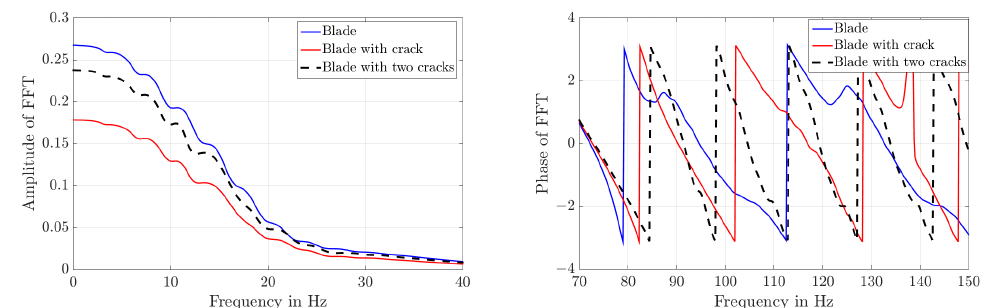
Figure 12. The amplitude and phase of the FFT for the signal are related to three different sim- ple blades.